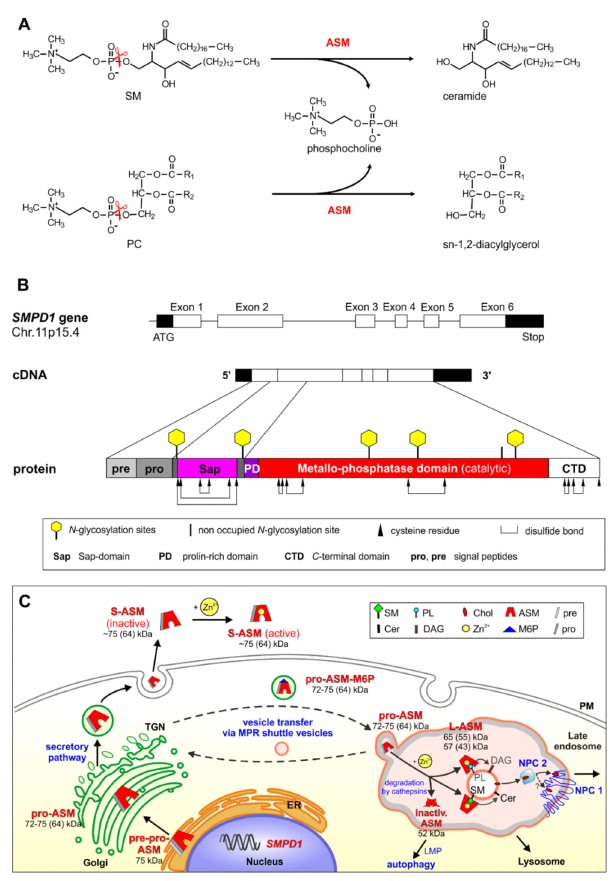
Figure 1. ( A ) ASM acts as an endolysosomal phospholipase C that cleaves off the phosphocholine residue from sphingomyelin and phosphatidylcholine. ( B ) Schematic illustration of the gene structure (exons represented in boxes), cDNA and processing structure of human ASM. The gene SMPD1 of the ASM has been mapped to the chromosomal region 11p15.4. Mature human ASM contains several domains: a signal peptide (amino acids 1–46), a Sap-domain (amino acids 89–165), a proline-rich domain (amino acids 166–198), the catalytic metallo-phosphatase domain (amino acids 199–461), and the C -terminal domain (amino acids 462–629). N -glycosylation sites and disulfide bridges are shown. ( C ) Topology of ASM processing. Pro-ASM is generated from pre-pro-ASM within the Golgi and is transported after mannose-6-phosphorylation by mannose-6-phosphate receptor mediated vesicle transfer to the endolysosomal compartments (L-ASM) or exported by the secretory pathway (S-ASM). In the endolysosomal compartment, the pro-ASM matures to the active forms. If L-ASM cannot interact with the intraendolysosomal luminal vesicles, the enzyme is degraded by cathepsins (inactivated ASM). This process leads to higher levels of sphingomyelin, which may disturb mem- brane homeostasis and cause lysosome membrane permeabilization (LMP), which triggers cell-death by apoptosis and apoptosis-like pathways. The molecular mass given in brakes is the deglycosylated form. ASM: acid sphingomyelinase, Cer: ceramide, Chol: cholesterol, CTD: C -terminal domain, DAG: diacylglycerol, ER: endoplasmic reticulum, L-ASM: lysosomal ASM, LMP: lysosome mem- brane permeabilization, M6P: mannose-6-phosphate, MPR: mannose-6-phosphate receptor, NPC 2: Niemann-Pick disease protein C type 2, PC: phosphatidylcholine, PD: proline-rich domain, PL: phospholipid, PM: plasma membrane, pre-pro-ASM: pre-pro form of ASM, pro-ASM: pro form of ASM, Sap: Sap-domain, S-ASM: secretory ASM, SM: sphingomyelin, TGN: trans Golgi